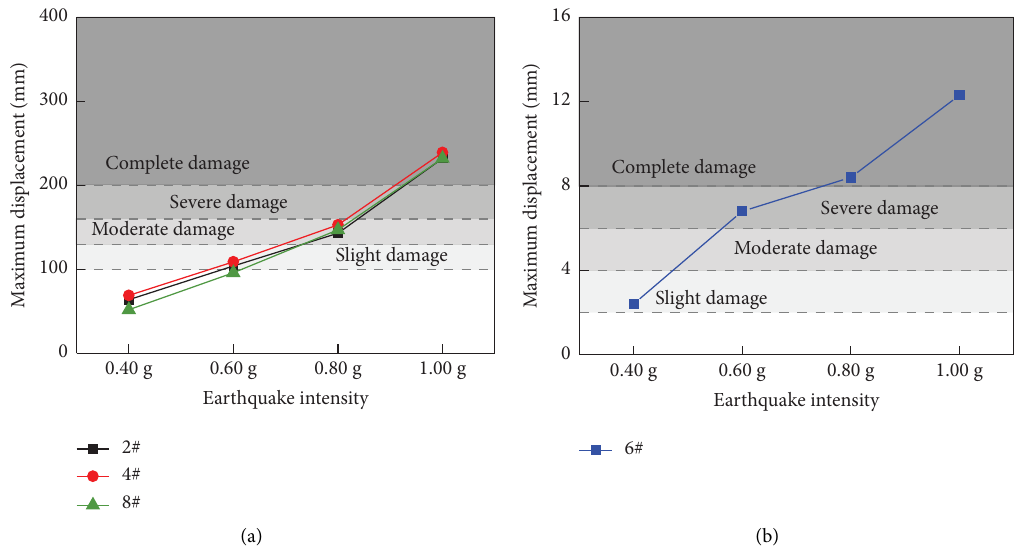
Figure 15: Damage levels of bearings under diferent earthquake intensities, for (a) longitudinal-movable bearings (2#, 4#, and 8#) and (b) fxed bearing